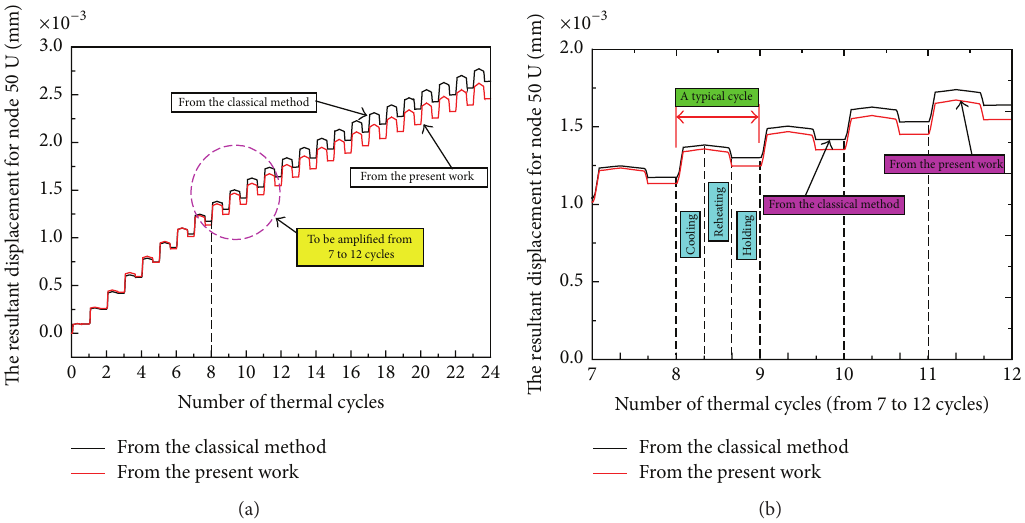
Figure 10: (a) The plot of the resultant displacement toward the outside direction for number 50 node which is located at the periphery of surface groove. (b) The details for the resultant displacement of number 50 node over 7 to 12 thermal cycles.